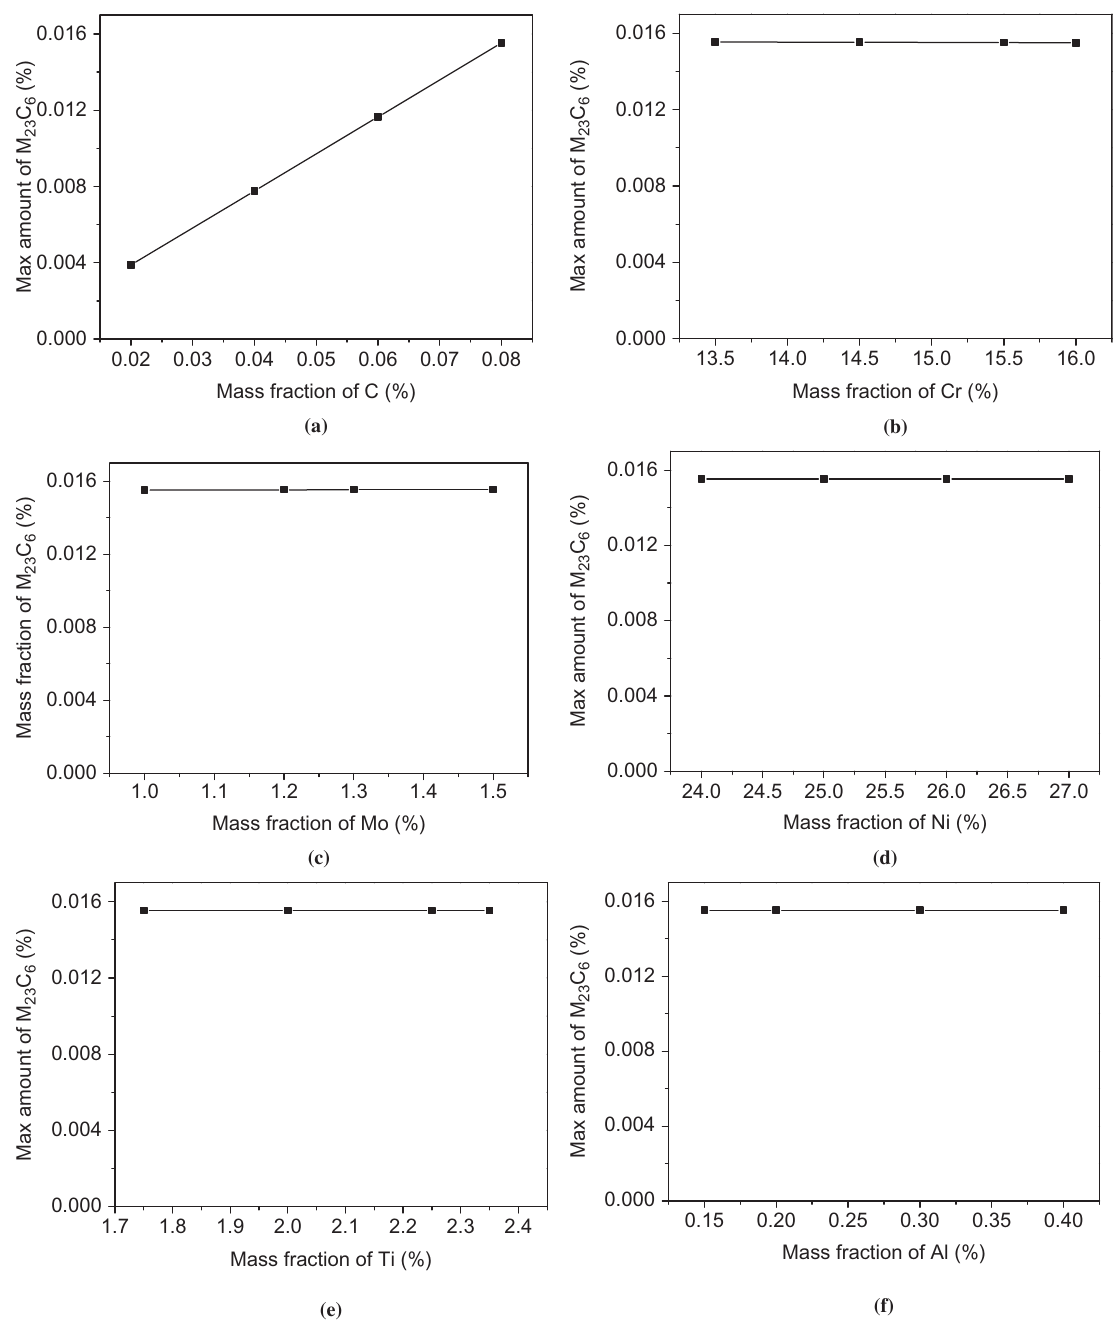
Figure 8: Variation of maximum precipitation amount of M 23 C 6 phase with the contents of (a) C; (b) Cr; (c) Mo; (d) Ni; (e) Ti; (f)